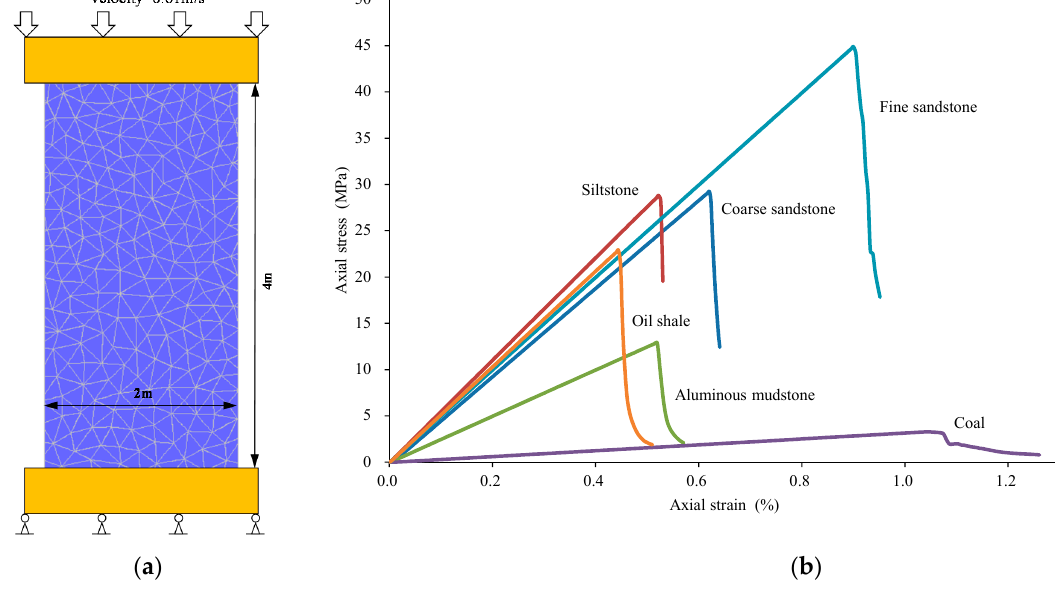
Figure 5. Calibration of coal and rock mass properties: ( a ) Calibration model; and ( b ) Predicted axial stress–axial strain curves of uniaxial compressive strength (UCS). Table 2. Calibrated micro-properties in the Universal Distinct Element Code (UDEC) Trigon model.